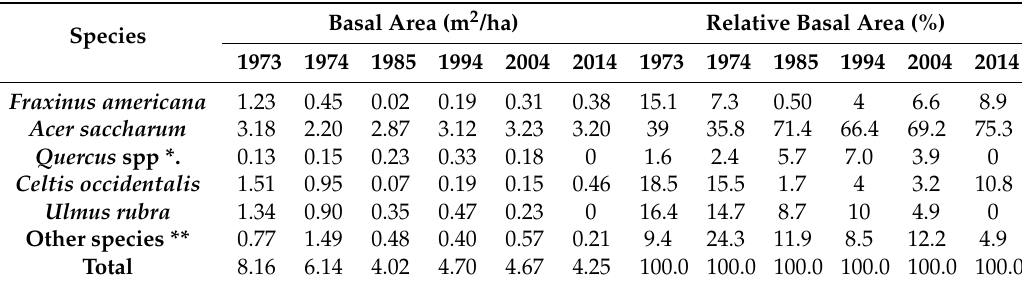
(DBH 10.0–29.9 cm) stratum at Dinsmore Woods recorded in the six sampling